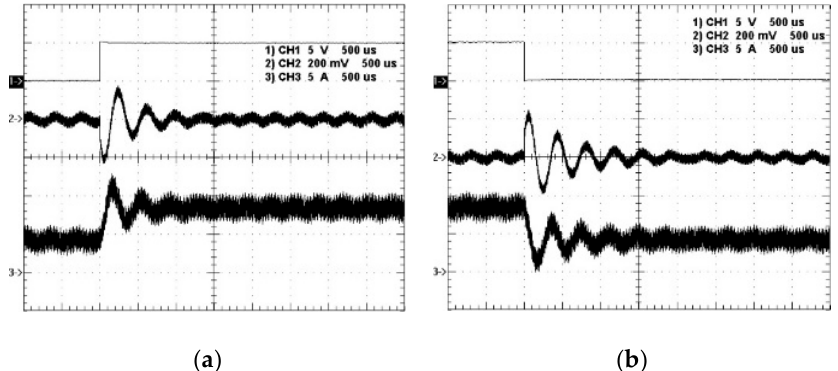
Figure 13. Waveforms based on the traditional PWM control strategy: (1) load enable; (2) AC output voltage; (3) inductor current, due to ( a ) from 50% to 100%; ( b ) from 100% to 50%.